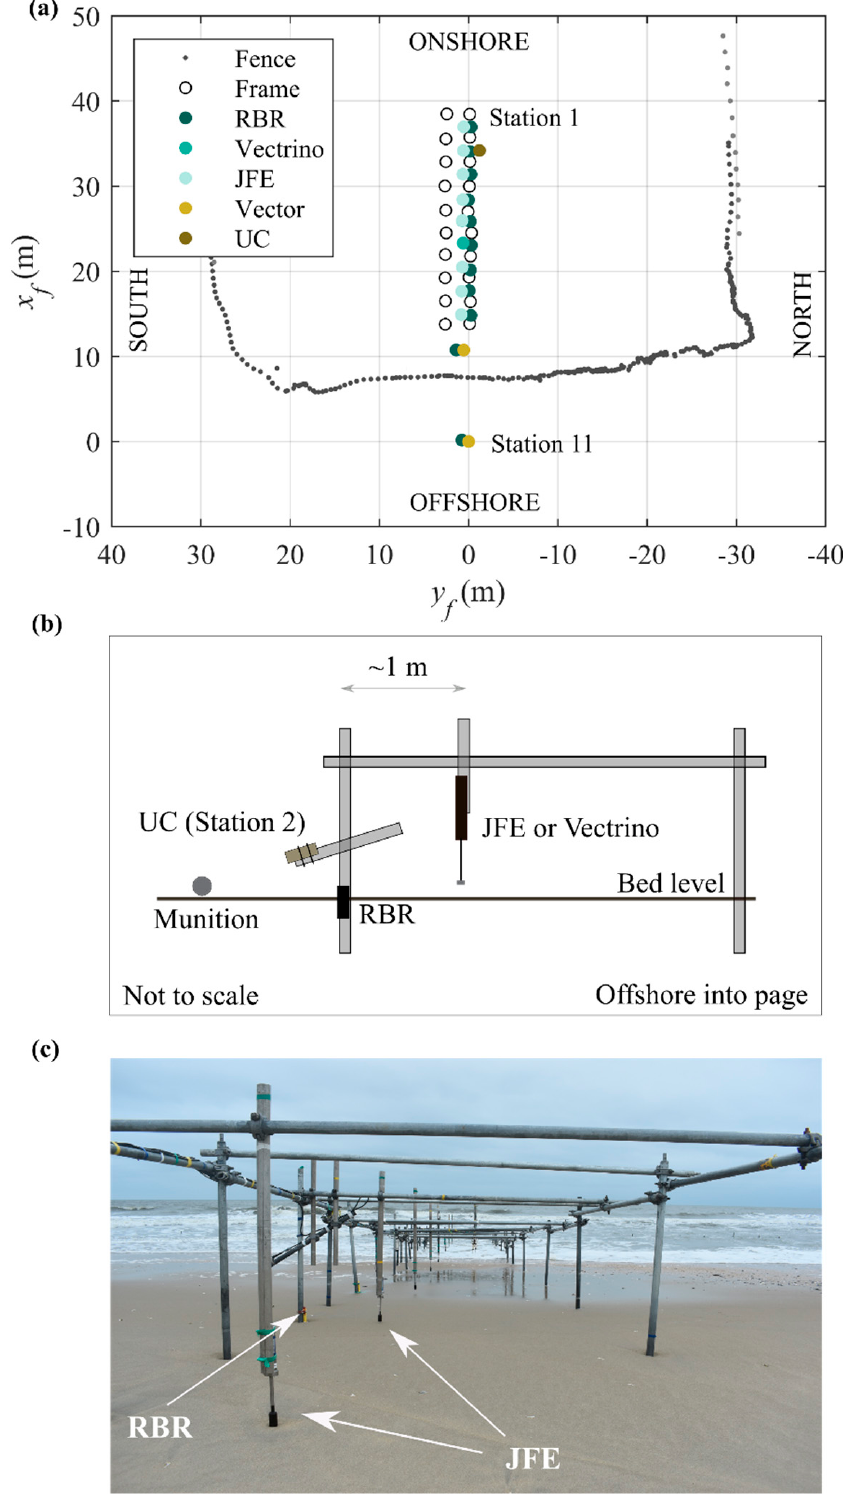
Figure 11. Field setup. ( a ) 2D map of deployed infrastructure and instrumentation in the local reference system. ( b ) Schematic of a generic instrumentation station (stations 1–9 only) with pipe and sensors configuration. ( c ) Photo of the frame scaffolding pipes holding instrumentation (offshore into page).